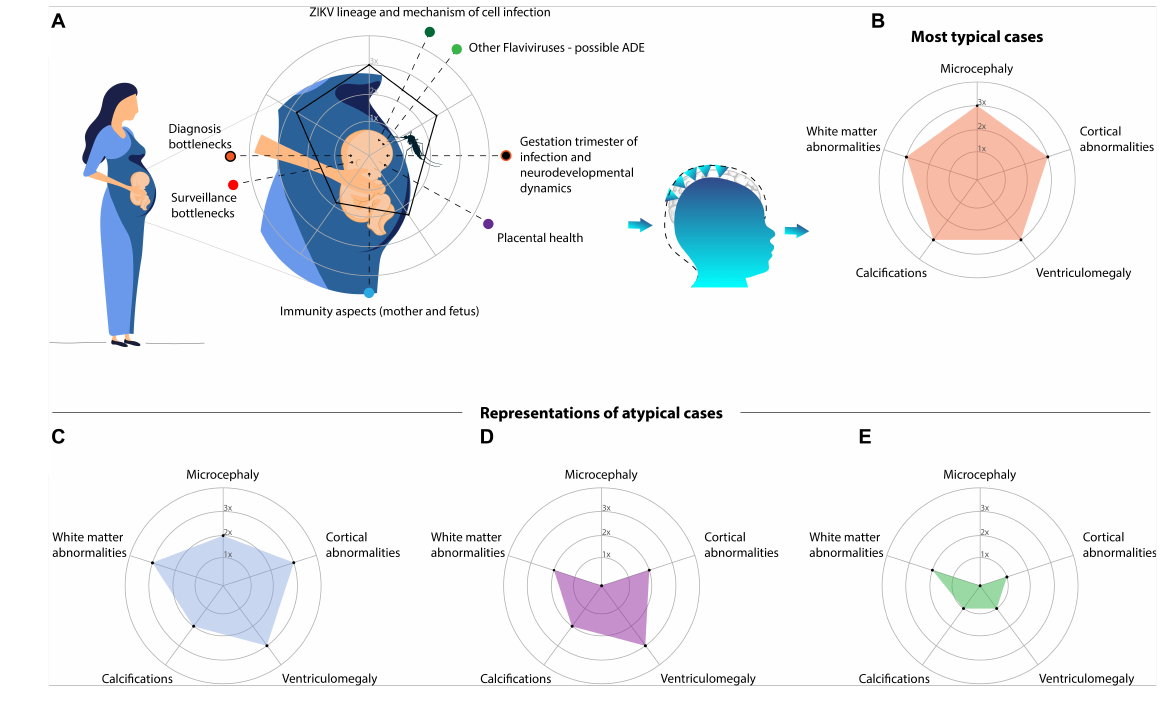
FIGURE 1 | Although ZIKV is well established as the cause of the CZS, the spectrum of outcomes is highly variable. (A) Depicts a schematic diagram of prenatal exposure to multiple variables. In this period, time-varying events and covariates hamper the precision in predicting the outcome, for which artificial intelligence (AI) algorithms may be crucial. The most important event is the timeline of the infection: presumably the earlier is the infection, the worse are the impairments. However, many other variables and possible confounders are present, such as: the viral lineage and the mechanism of infection; overlapping infections of other flaviviruses that might lead to an antibody-dependent enhancement (ADE); misdiagnosis due to surveillance pitfalls or intrinsic diagnostic difficulties; immune-response of the mother (including placental health) and fetus. In addition, four examples of the CZS spectrum are represented in radar charts (axes with arbitrary values). Alterations driving the different phenotypes are grouped and oversimplified. (B) Is the pentagon, a typical and severe case which is readily detected, not necessarily diagnosed due to a possible lack of laboratorial confirmation. The other phenotypes are frequently neglected: (C) represents less severe cases (in comparison to the typical one), though noticeable, in the lack of laboratorial confirmation it might depend on the monitoring; (D) represents the pseudo-normocephalic cases, clinical alterations and neuroimaging may be crucial; (E) represents mild cases with subtle alterations within the gray and/or white matter, which are particularly challenging to detect and consequently the most neglected.